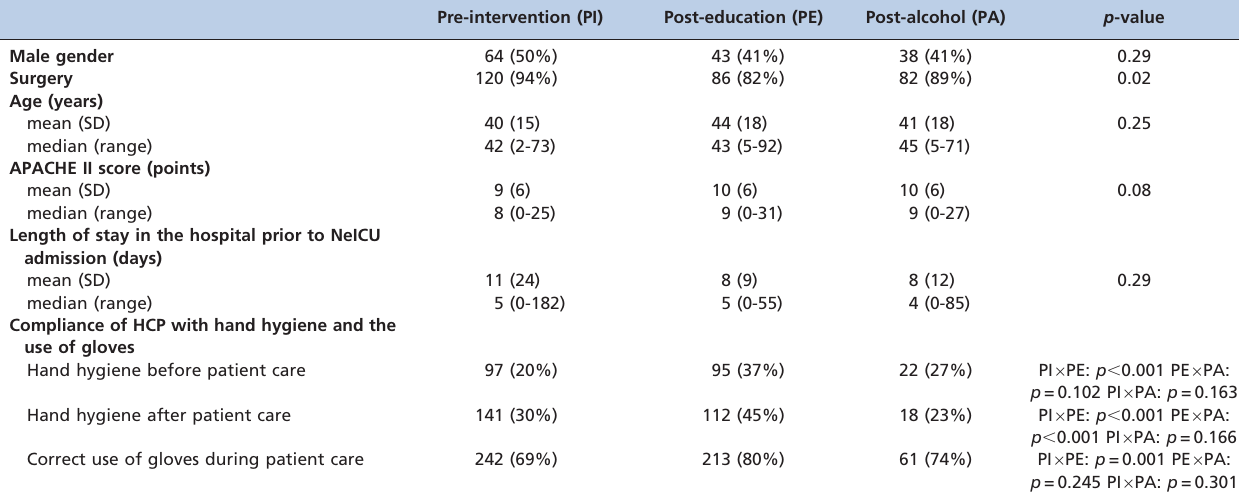
Table 1 - Characteristics of patients and compliance with hand hygiene and the use of gloves during the three study periods.